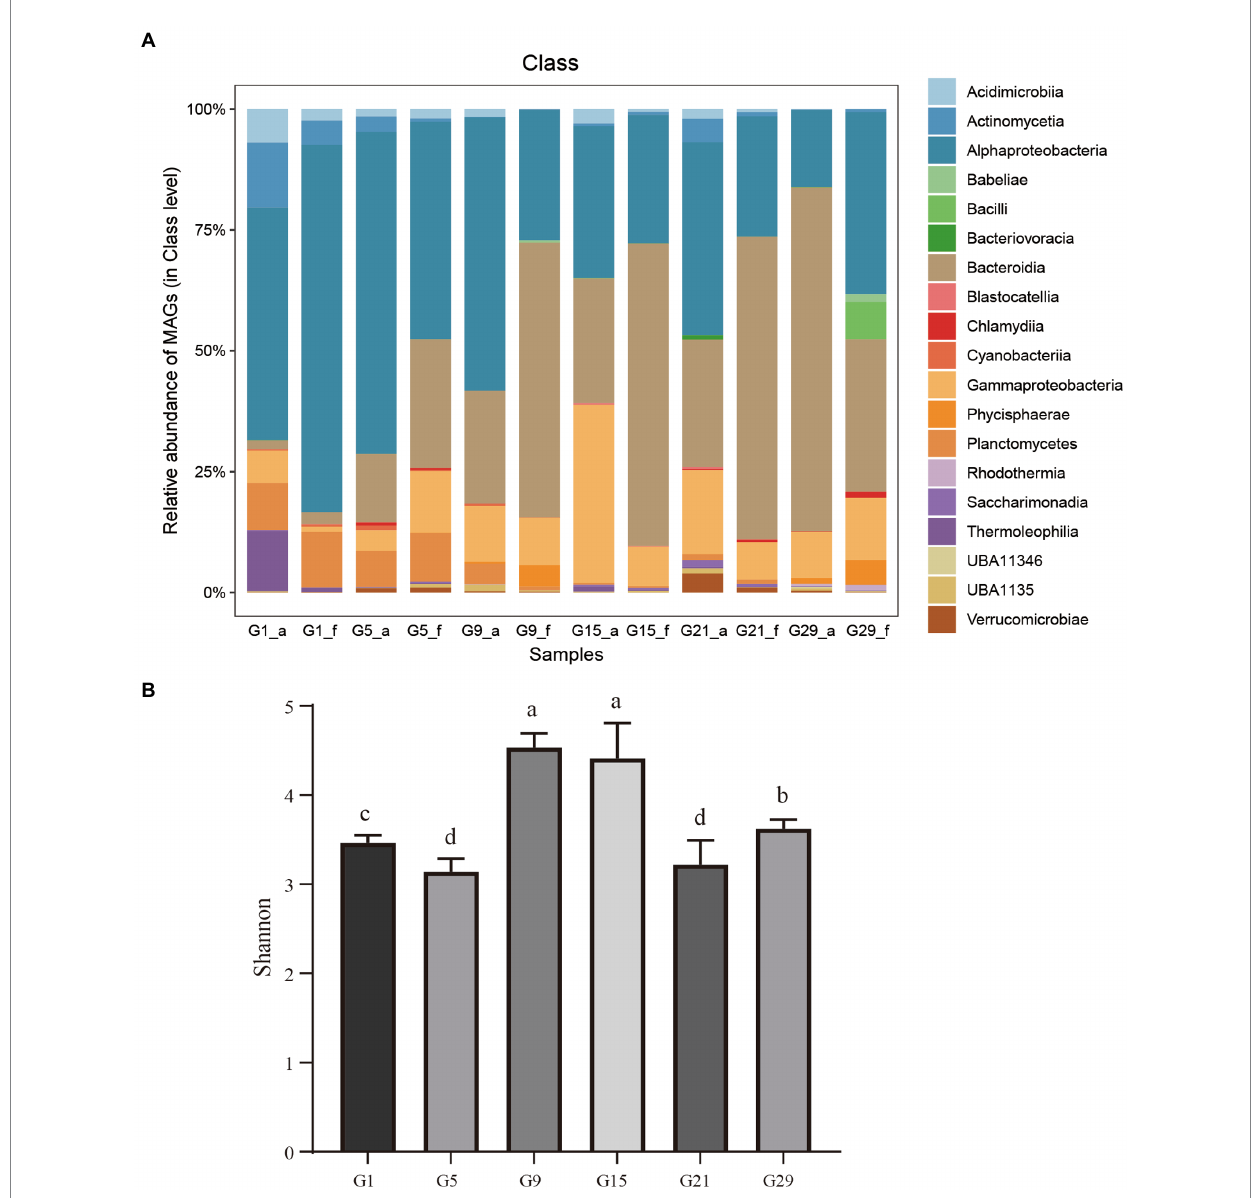
FIGURE 3 (A) The relative abundances of the bacterial MAGs. On the x-axis, the lowercase letter “f” in the sample names indicates the free-living bacteria, and “a” indicates the attached bacteria ( n = 3). (B) Bacterial community alpha diversity at different bloom stages as expressed by the Shannon diversity indices. Values are means of triplicates ± SD. Different lowercase letters (a–d) on the bars represent statistical significance between time points at p < 0.05 (Student’s t